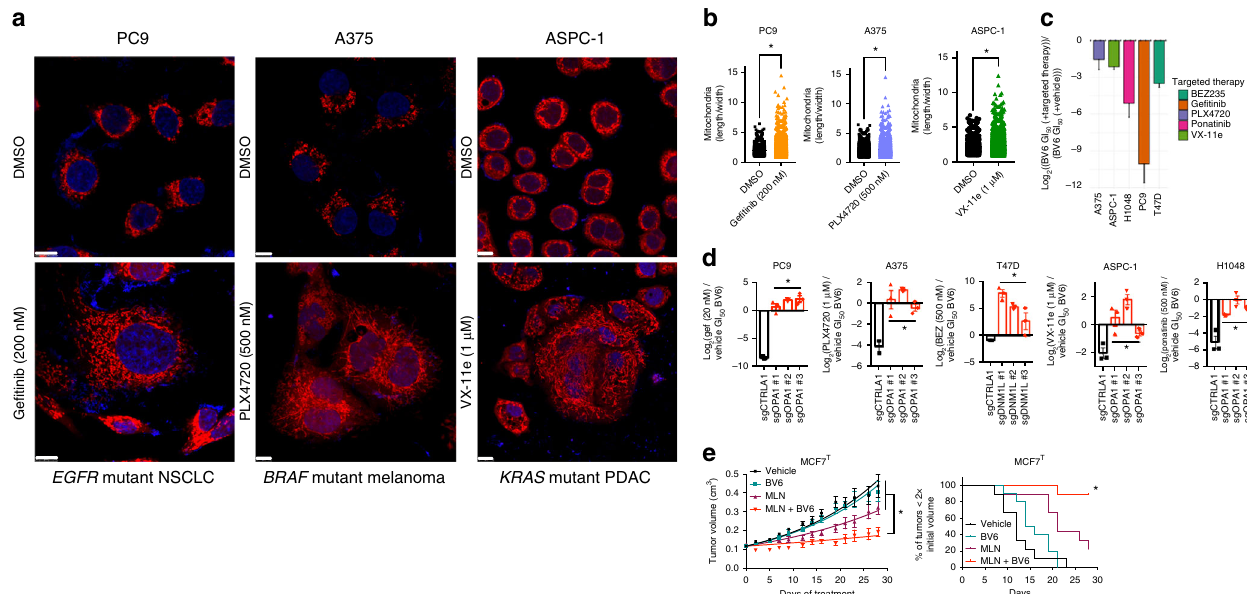
Fig. 6 Oncogenic control over mitochondrial dynamics can be exploited therapeutically using targeted therapies to create a vulnerability to SMAC mimetics. a Mitotracker and DAPI in three cell lines PC9 (scale bars 10 μ m), A375 (scale bars 7.5 μ m), ASPC-1 (scale bars 10 μ m) treated with vehicle or one of three inhibitors (ge fi tinib, PLX4720, VX-11e). Immuno fl uorescence images are representative of two independent experiments. b Quanti fi cation of images from Fig. 5a and Supplementary Fig. 5a. Mitochondrial length × width is plotted for thousands of mitochondria from >10 cells across at least